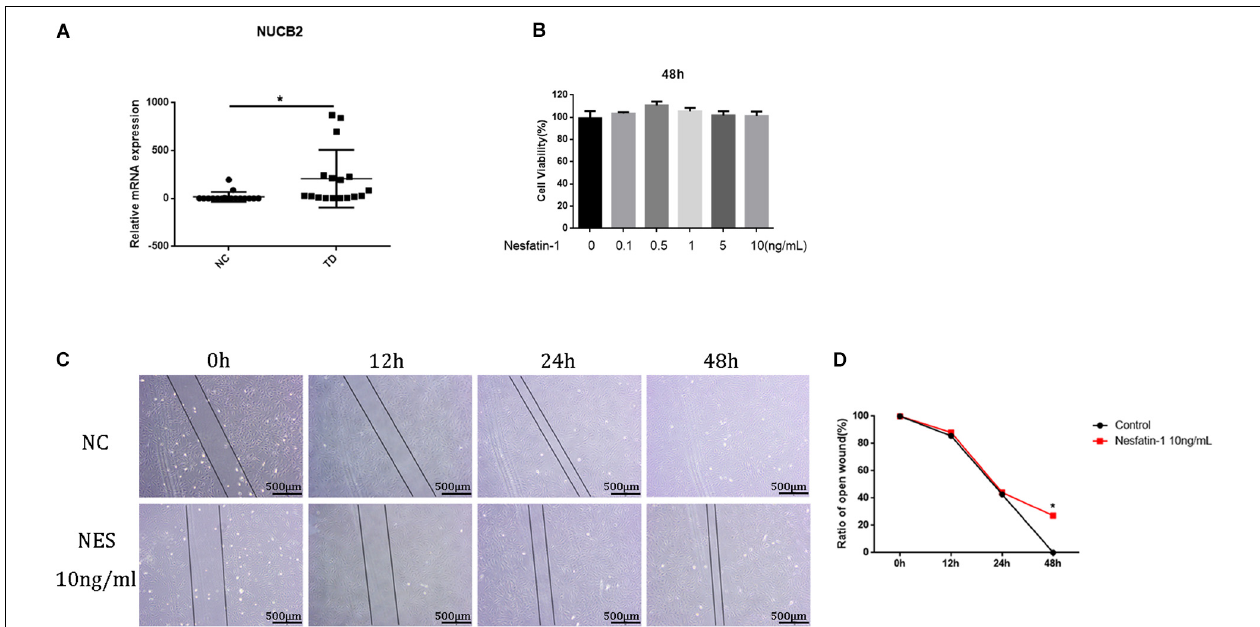
FIGURE 2 | Cell viability assay. The expression of NUCB in human tendon tissues was detected by qRT-PCR. (A) The TDSCs were treated with increasing concentrations of Nesfatin-1 (0, 0.1, 0.5, 1. 5, or 10 ng/mL) for 48 h. (B) The effects of Nesfatin-1 on rat TDSCs viability were evaluated by the CCK-8 assay. (C,D) a scratch assay was used to evaluate the effects of Nesfatin-1 on the ability of TDSCs to migrate. Scale bar, 500 µ m. * p < 0.05.